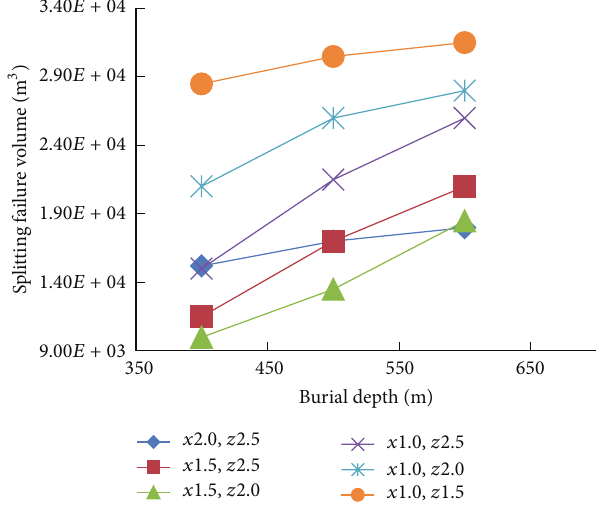
Figure 12: Splitting failure volume versus burial depth under varying lateral pressure coefficient.